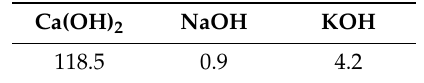
Table 1. The components of alkaline solution [g/L].